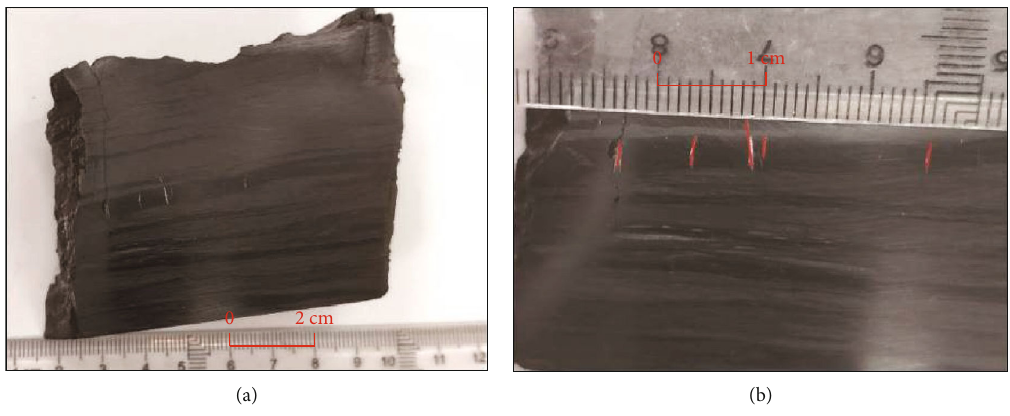
Figure 4: Fractures (cm-scale) developed in coal